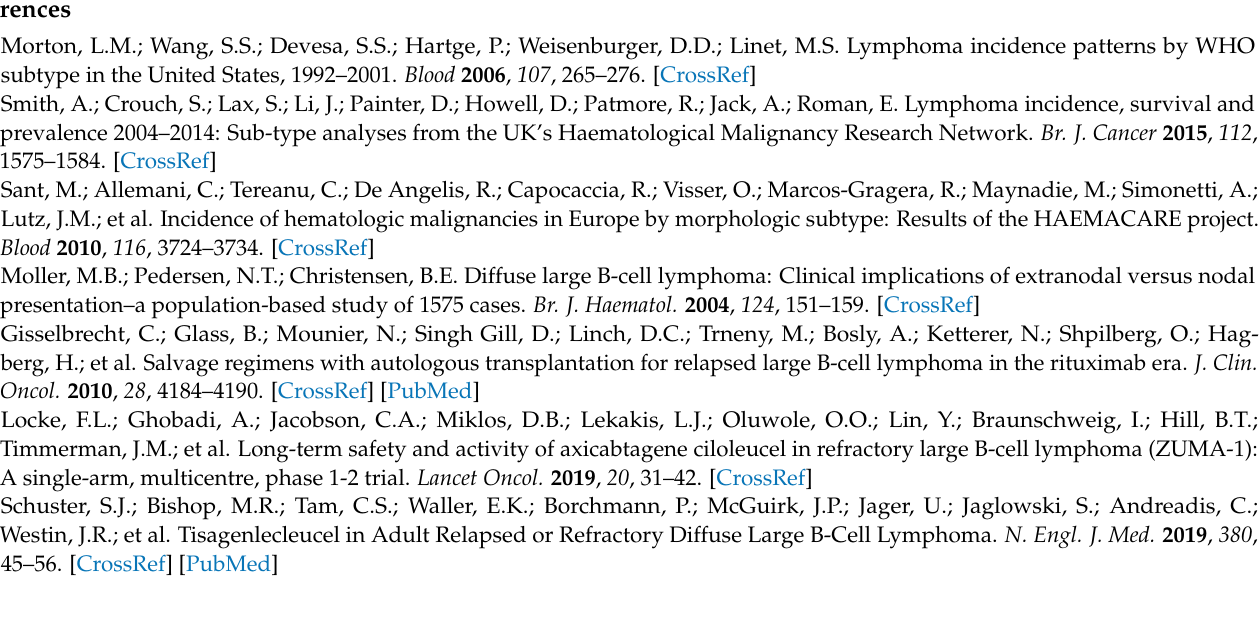
eosin staining, Table S3: Sequencing quality data, Table S4, 1–12: Somatic, exonic mutations detected in patients 1–12, Table S5: Suggested driver mutations with stable allelic frequencies (AF) across all the biopsies (B) of a patient, Table S6: Selected genes for exon